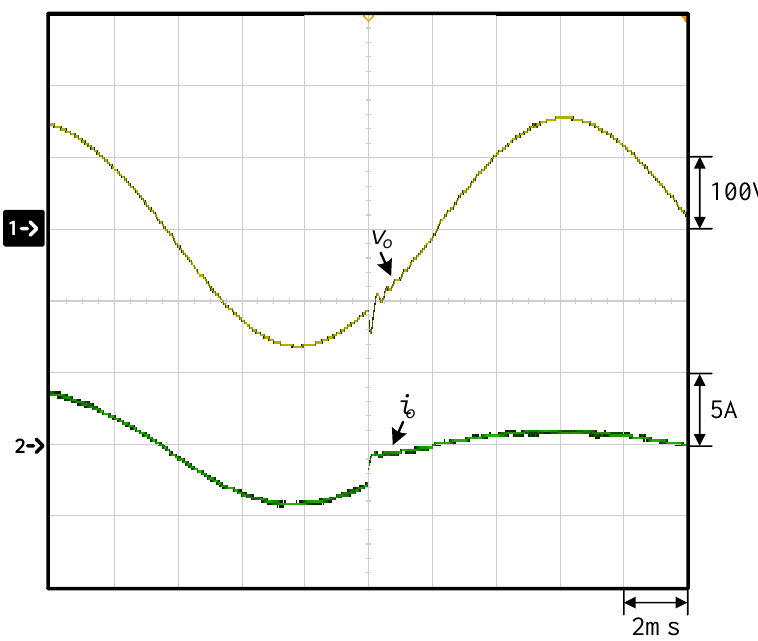
Figure 20. Measured waveforms of uploading from 25% load to 100% load: (1) v o ; (2) i o .